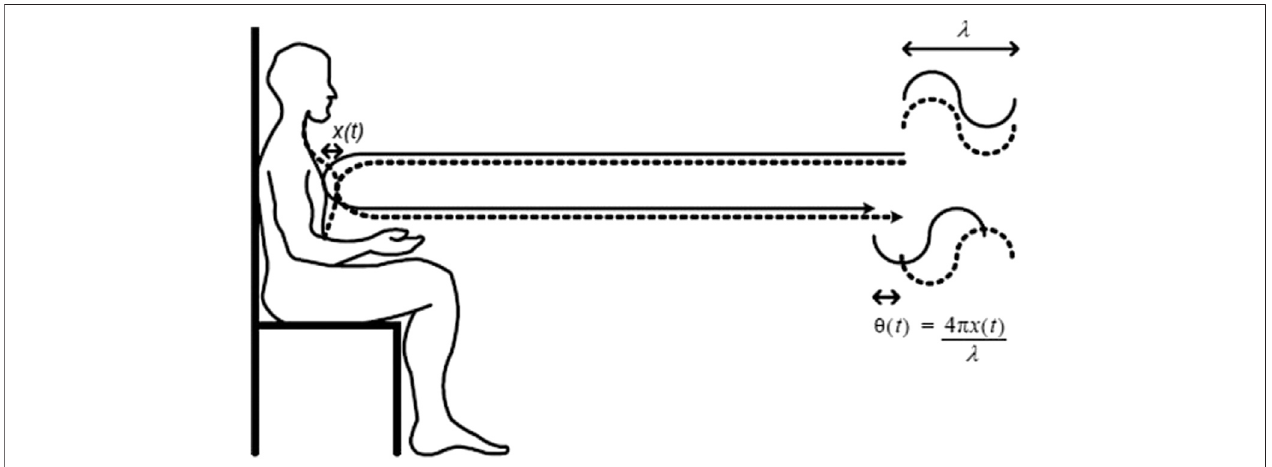
FIGURE 2 | Doppler transceiver functionality. A typical single channel Doppler radar trasnceiver, (A) , is used to produce time varying signals and spectra, (B) resulting from a human subject 1.5 m away from the radar. From Li et al. (2013).